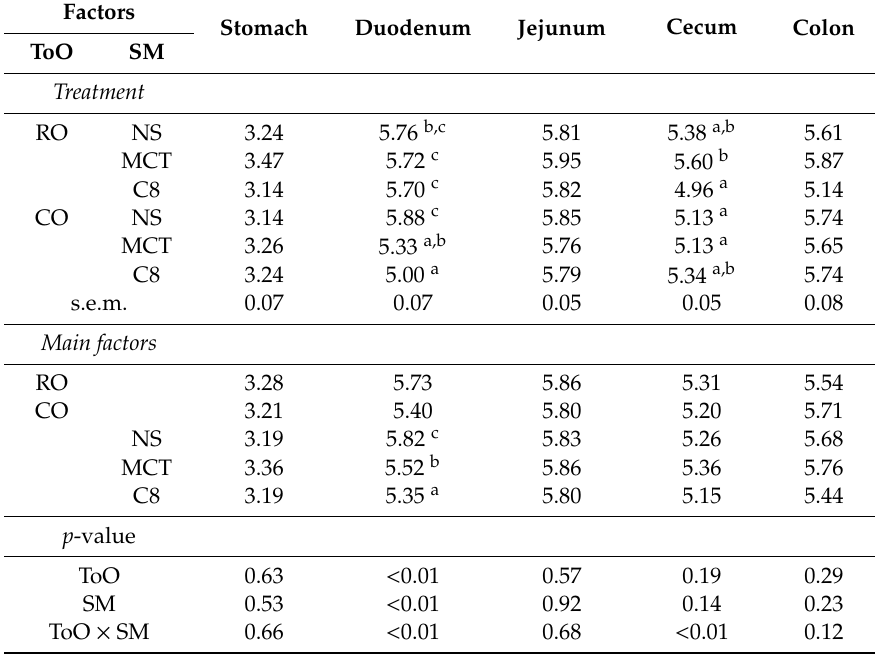
Table 6. Acidity of chyme in the stomach and in various parts of intestines in piglets at 60th day of